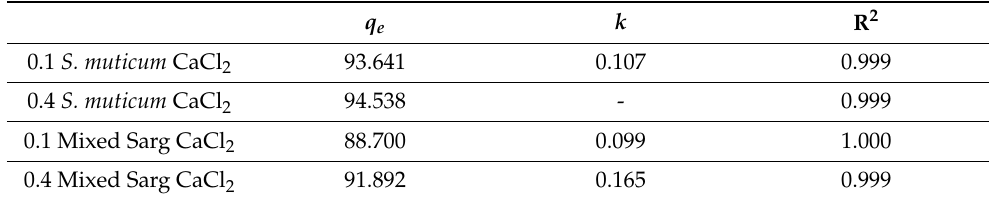
Table 1. Kinetic parameters q e is the amount of dye adsorbed at equilibrium, k is the adsorption rate constant and R 2 is the coefficient of determination between calculated and average experimental